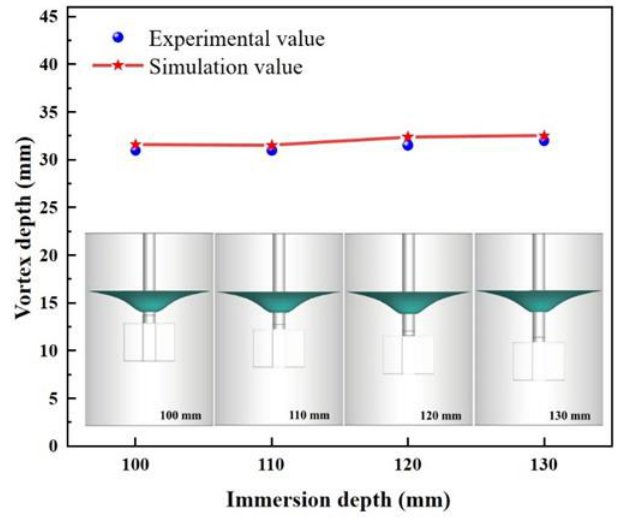
Figure 16. Vortex depth and gas – liquid interface profile at different IIDs with IRSs of 180 rpm.